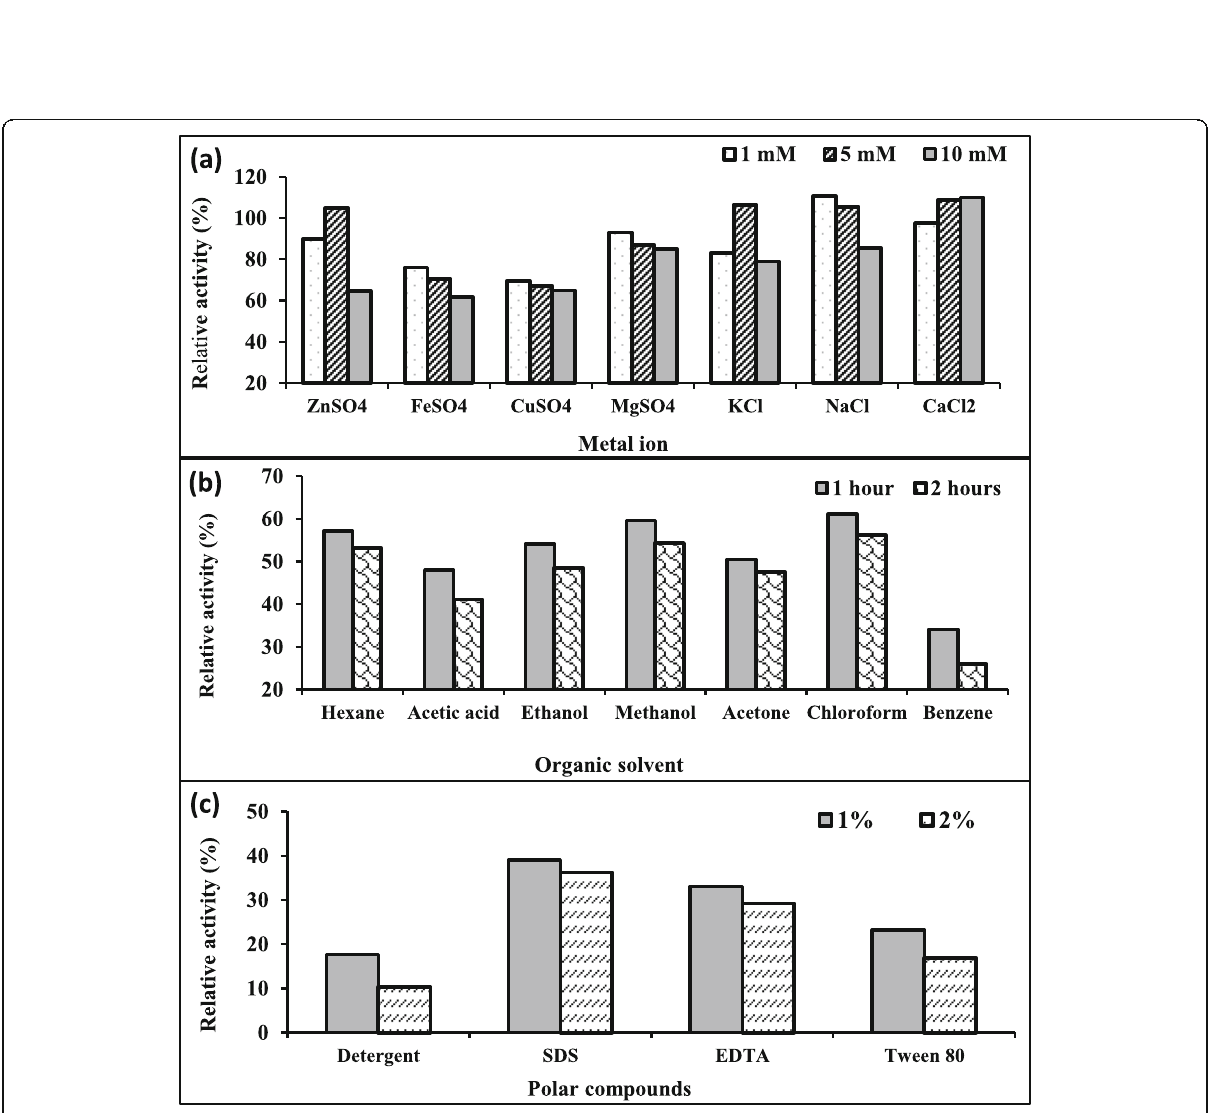
Fig. 5 Effect of metal ions ( a ), organic solvents ( b ), and surfactant materials ( c ) on lipase produced by R. oryzae R1. Initial activity (100%) =